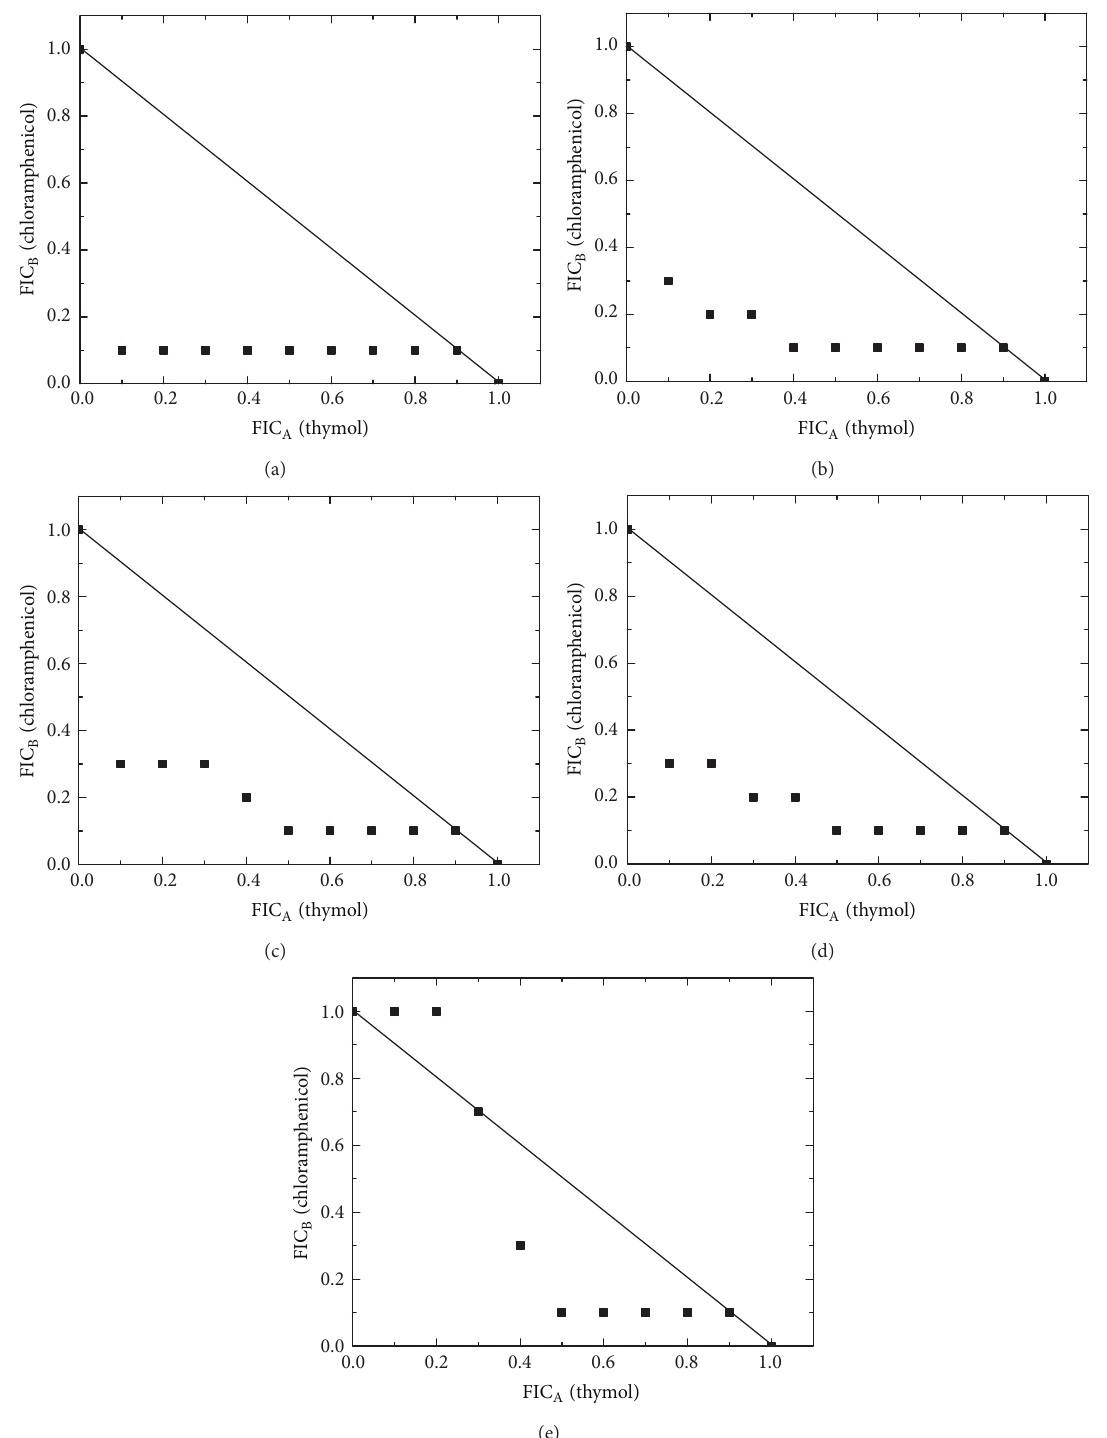
Figure 3: The derived isobolograms for the interaction of thymol-chloramphenicol and their treatment outcomes against the following: (a) E. coli ATCC 25922, (b) K. pneumoniae ATCC 700603, (c) P. mirabilis ATCC 12453, (d) P. aeruginosa ATCC 27853, and (e) S. aureus ATCC